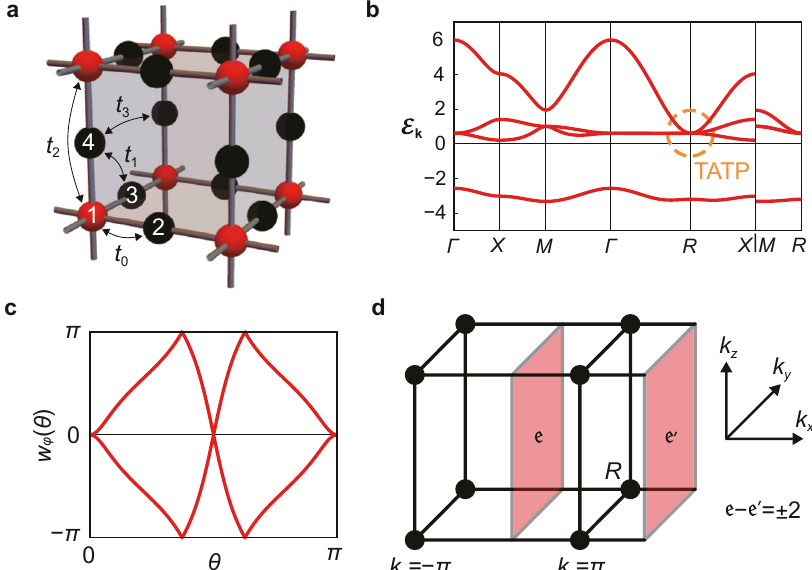
Fig. 4 Avoiding the doubling theorem in 3D electronic Lieb model. a 3D Lieb lattice structure with four sites in a unit cell. b The electronic band structure with a single TATP at R . Here Γ = (0, 0, 0), X = ( π , 0, 0), M = ( π , π , 0), and R = ( π , π , π ). We refer to the highest energy mode forming the TATP as the L mode, and the lower two energy modes forming the TATP as the T modes. c Wilson loop spectrum for the second and third lowest bands, corresponding to T mode of the TATP, computed over a sphere with radius 0.1 π centered at R . The winding structure shows that j e j ¼ 2. d With a single TATP at R (black dots), it is not possible to de fi ne e in the ( k y , k z ) plane since it con fl icts with the periodicity of the Brillouin zone. This contradiction is resolved by noticing the π Zak phases along the k x , k y , k z directions, so that e is ill de fi